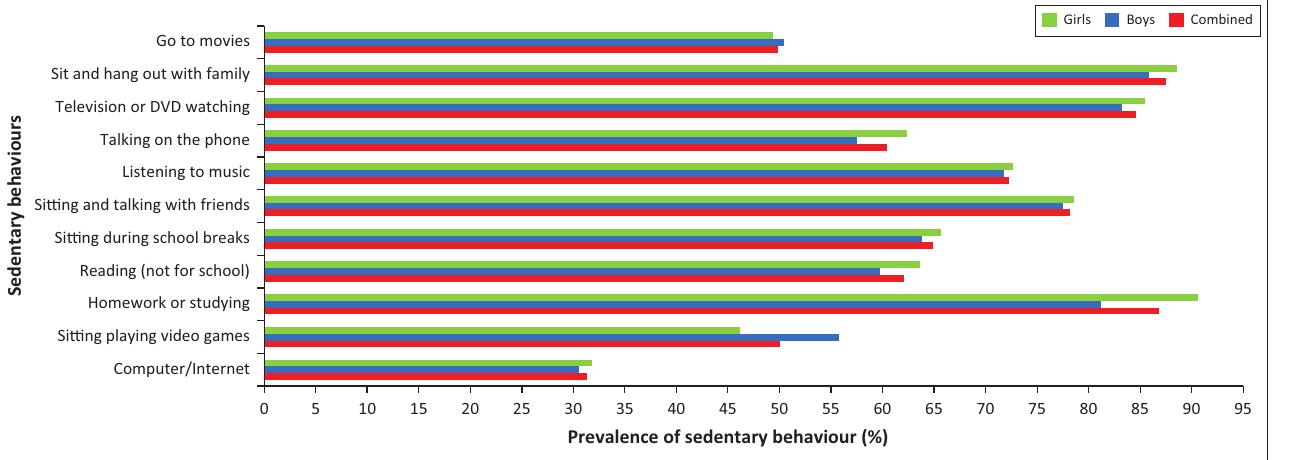
FIGURE 1: Types of sedentary